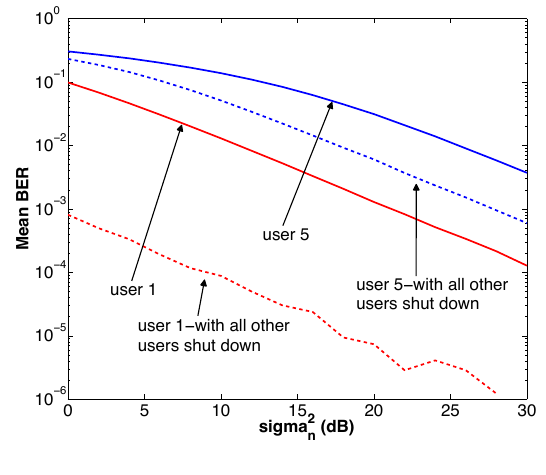
Figure 6. BER Performance of users compared to TDMA (SISO BC). BER performance is better for the case that only one user is active (TDMA).